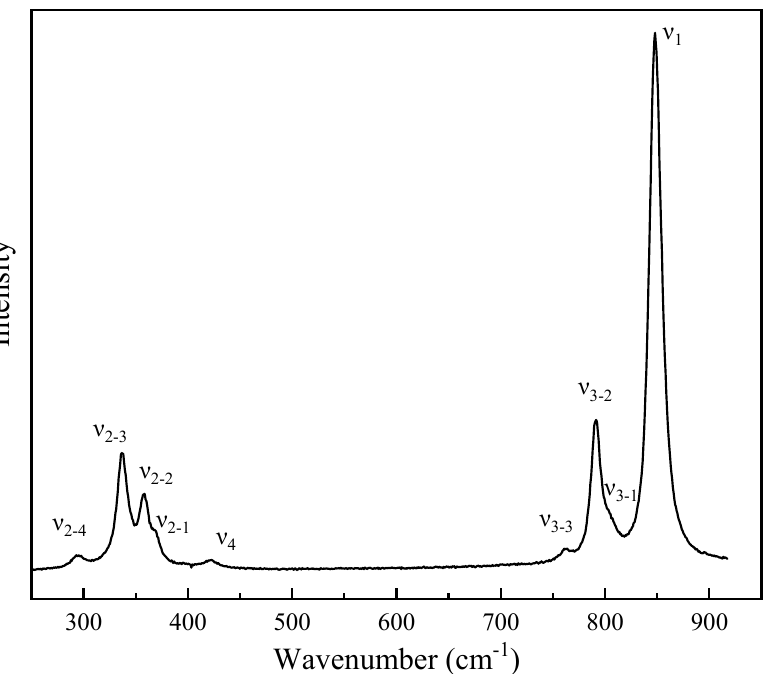
Figure 5. Representative Raman spectrum of vanadinite at ambient conditions. Ten HP Raman spectra were collected from 7.3 GPa and up to 26.8 GPa. Seven Raman